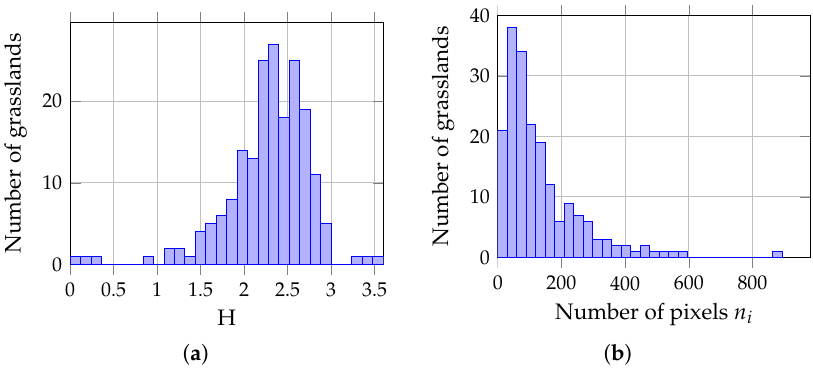
Figure 2. Histogram of ( a ) Shannon index H and ( b ) grasslands’ size in number of pixels n i .